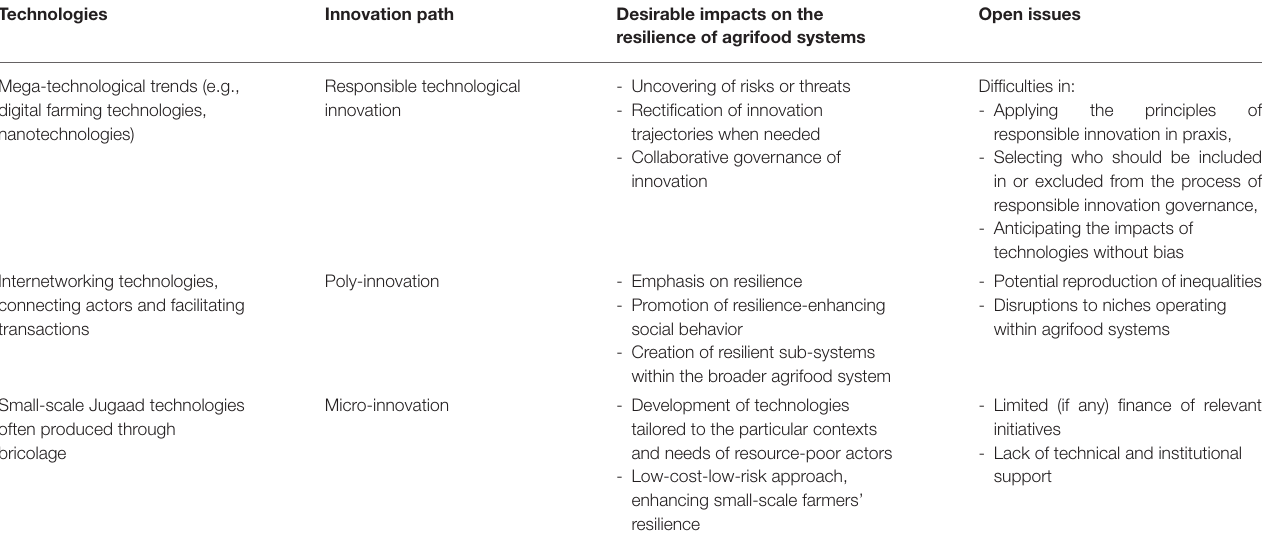
TABLE 1 | Sets of technologies, associated innovation paths, links with agrifood systems resilience, and open